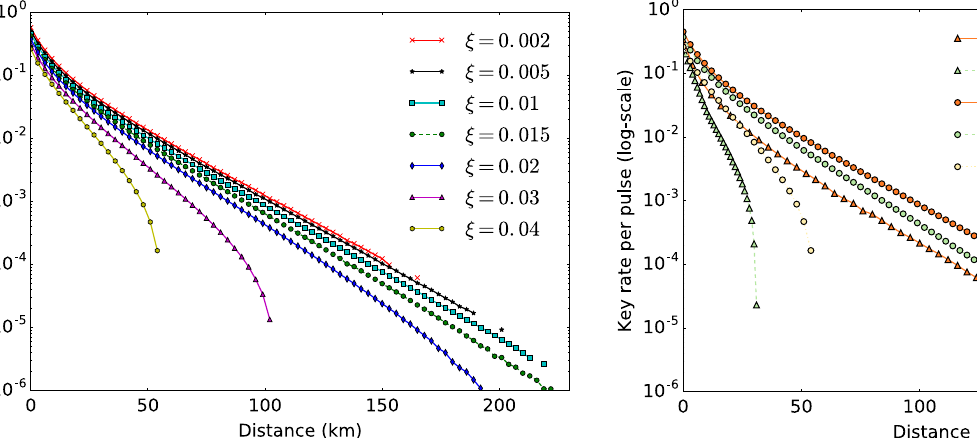
FIG. 7. Secure key rate versus the transmission distance for protocol 2 with heterodyne detection for different values of the excess noise ξ , from top to bottom, ξ ¼ 0 . 002 , 0.005, 0.01, 0.015, 0.02, 0.03, 0.04. The coherent state amplitude is optimized via a coarse-grained search over the interval [0.6, 0.92], the trans- mittance is η ¼ 10 − 0 . 02 L for each distance L in kilometers, and the reconciliation efficiency is β ¼ 0 . 95 .